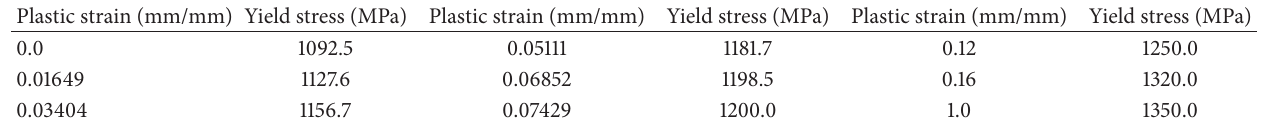
Table 2: Parameters for tabular hardening curve.